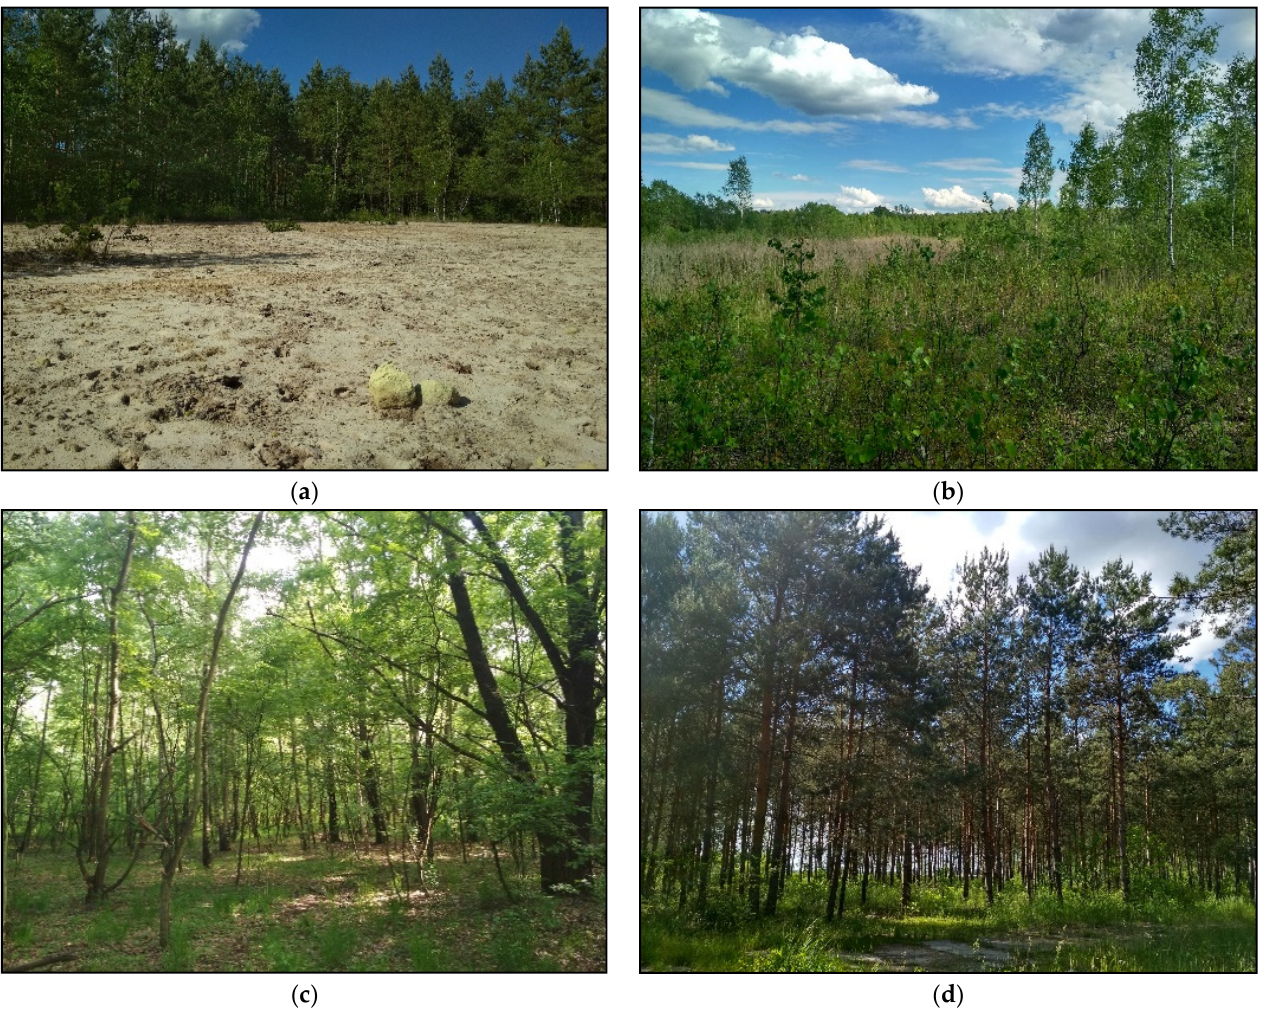
Figure 2. Scenes for the Jeziórko LULC classes: ( a ) mineral extraction sites, bare sand with sulfur contamination on the surface; ( b ) transitional woodland shrub, trees and bushes; ( c ) broad-leaved forest, i.e., oak, birch; ( d ) coniferous forest—scots pine.